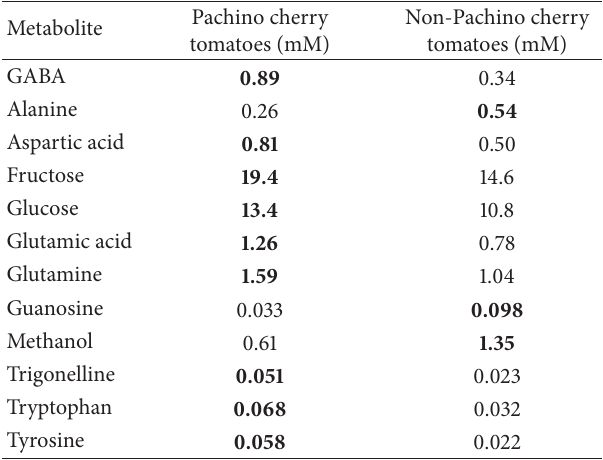
Table 1: Comparison between the statistically significant average metabolite molar concentrations of Pachino cherry tomatoes and of non-Pachino ones. Besides, we signed in bold the metabolites with the higher